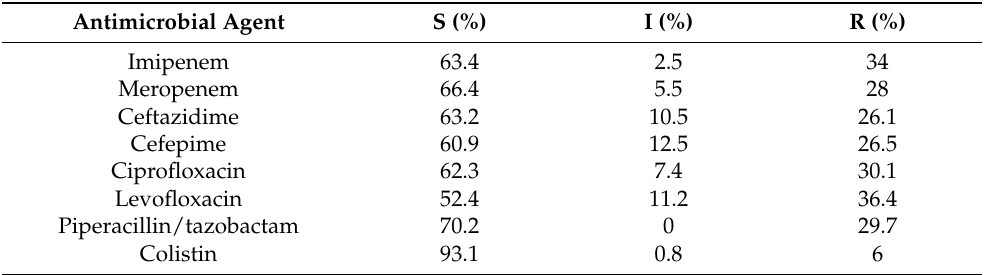
Table 1. Susceptibility data of P. aeruginosa isolates expressed as mean rate for the entire study period of the four years following the Clinical and Laboratory Standards Institute criteria.